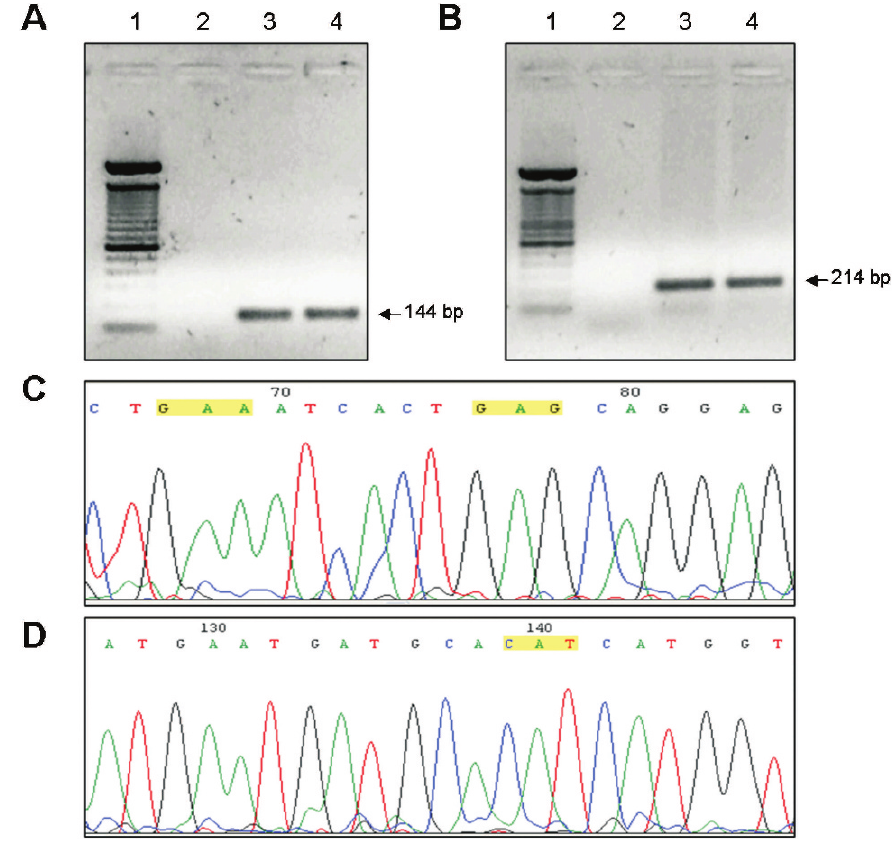
Figure 1 - PCR and Sequencing of exons 9 and 20 of PI3K . The fragment size of the exon 9 (A) and exon 20 (B) of PI3K are indicated in the figure. In both figures A and B, lane 1: Ladder 100bp fragments; lane 2: negative control; lanes 3 and 4: amplicons obtained from genomic DNA of patient MDS patients (RA). Representative PI3K sequencing from MDS patients, determined by automated sequence analysis of exon 9 (C) and 20 (D). The localization of the most frequent hotspot mutations are highlighted in the